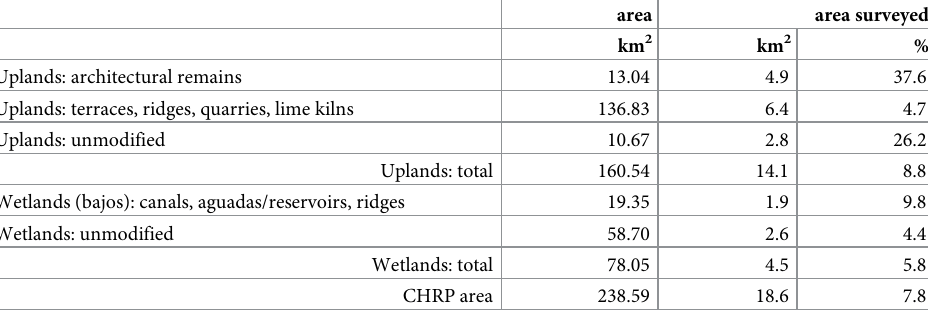
Table 1. Coverage of field surveys in the CHRP